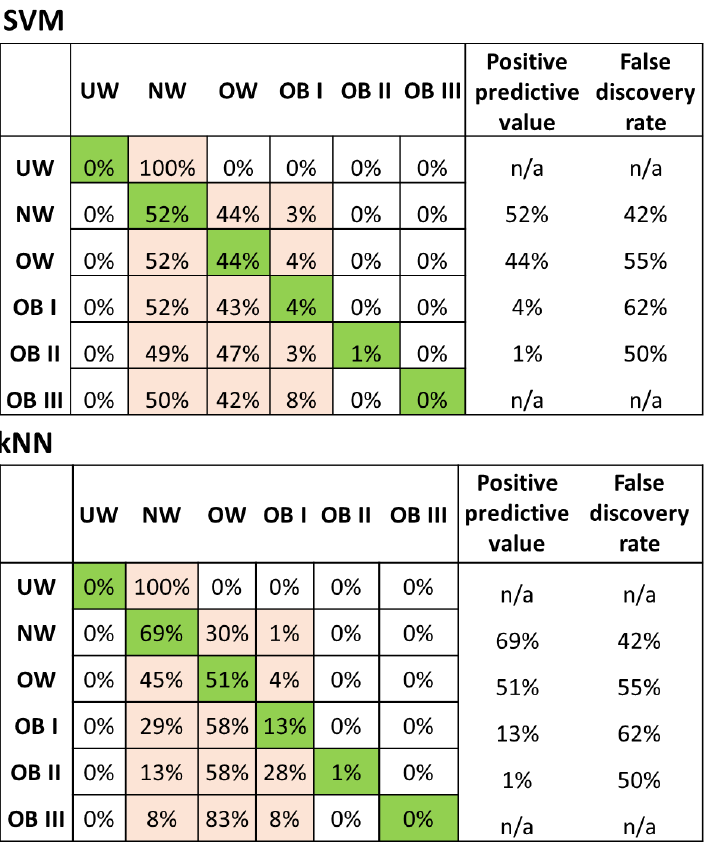
Figure 3. Confusion matrix for the ensemble tree with the subspace method, using nearest neighbor learners. Green color boxes indicate positive predictions and cream color boxes indicate